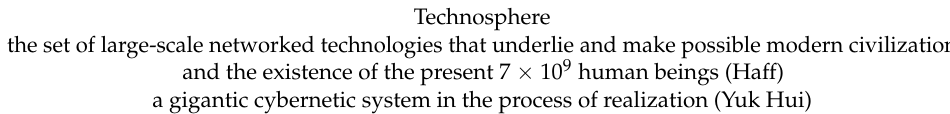
Table 2. Technosphere, Technocene, and